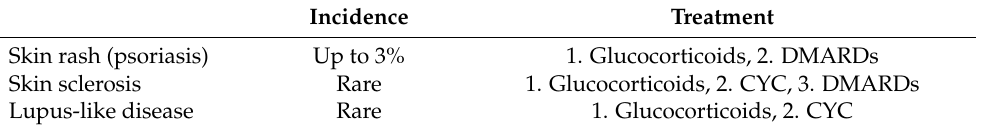
Table 1. Cont. Incidence Treatment Skin rash (psoriasis) Up to 3% 1. Glucocorticoids, 2. DMARDs Skin sclerosis Rare 1. Glucocorticoids, 2. CYC, 3. DMARDs Lupus-like disease Rare 1. Glucocorticoids, 2.